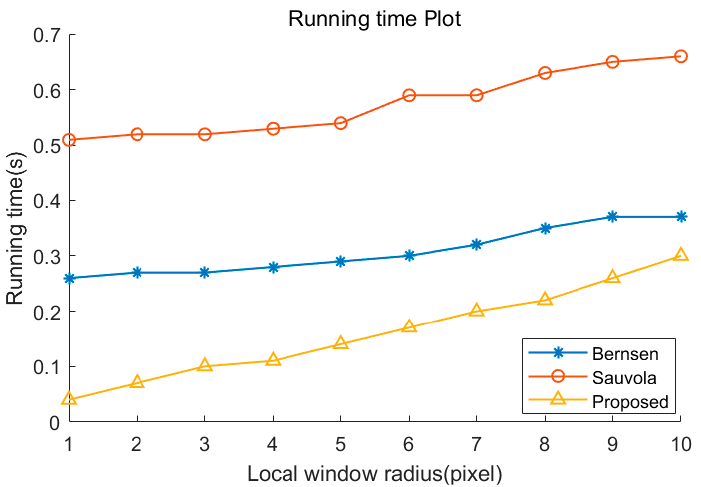
Figure 19. Processing time of Bernsen, Sauvola, and proposed method.